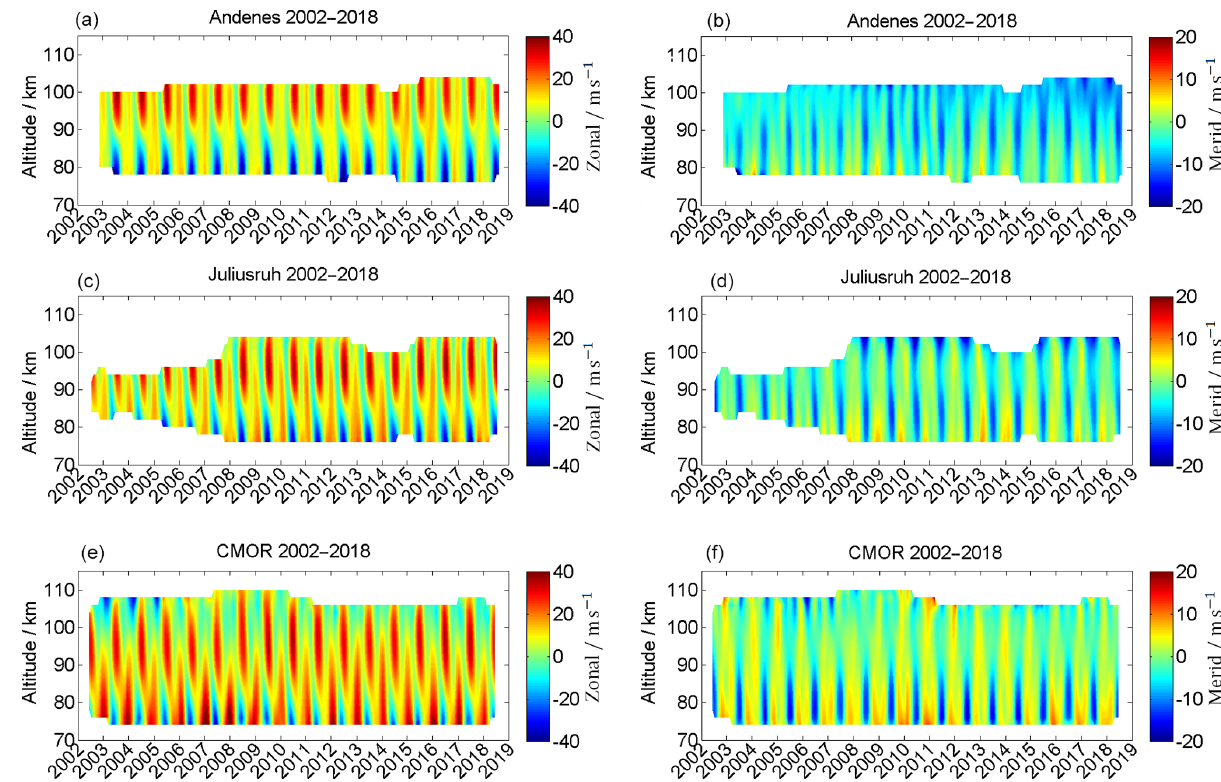
Figure 4. Seasonal mean zonal (a, c, e) and meridional (b, d, f) wind components for Andenes (a, b) , Juliusruh (c, d) , and CMOR (e, f) for the locations according to available data series. Note the different labels of the color